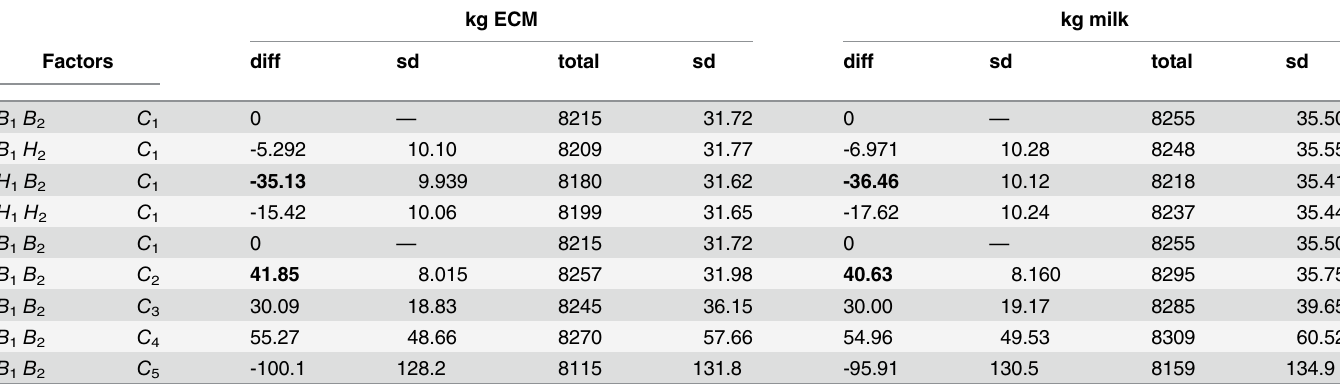
Table 3. Milk production in parity one, all offspring groups.